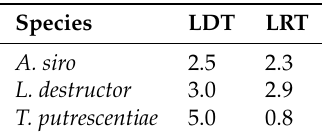
Table 7. Comparison of lower respiration (LRT) and lower development (LDT) thresholds in